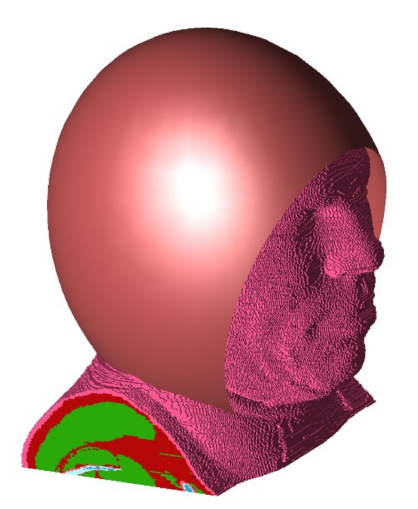
Figure 3. Model of head with metal surface